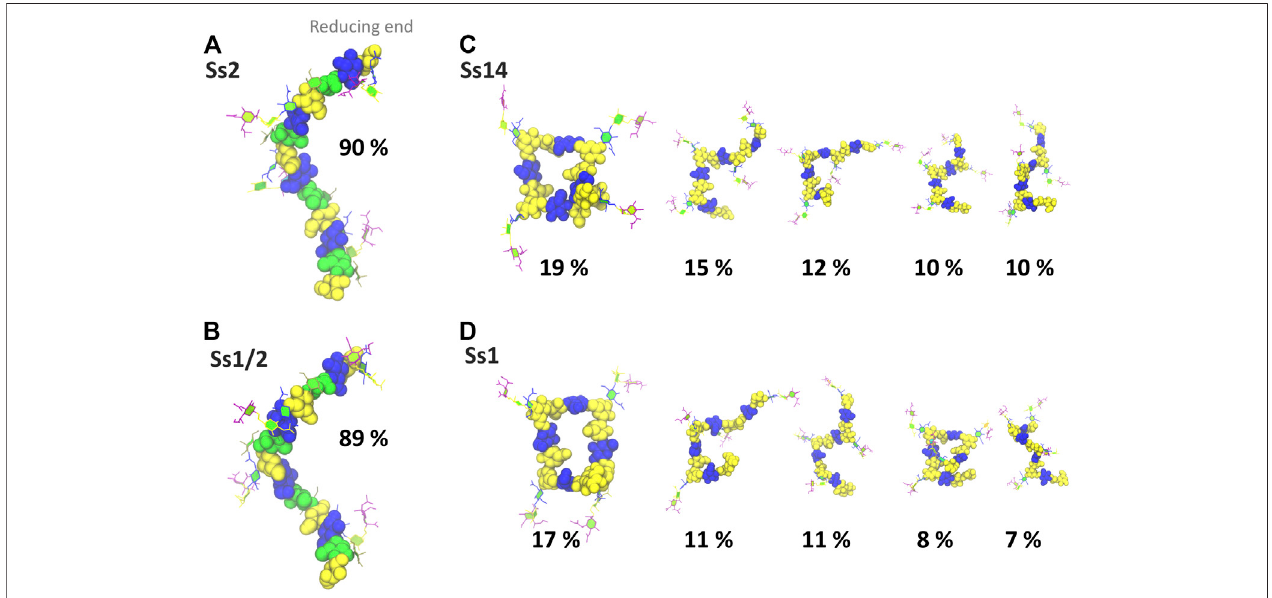
FIGURE 3 | Main conformational families and associated percentages of the CPS molecules shown with the side chains in the PaperChain visualisation and the CPS backbone in a space- fi lling representation. Representative conformations for RU 2 – 5 (excluding the fi rst and last RU) are shown for (A) Ss2; (B) Ss1/2; (C) Ss14; and (D) Ss1. Conformations are scaled according totheir relative percentage occupancies, and clusters less than 6% are notshown. The residues inall representations are coloured in keeping with the SNFG, as follows: β D Gal and β D GalNAc — yellow; α D Gal — brown; β D Glc — blue; β L Rha — green; α D Neu5Ac —